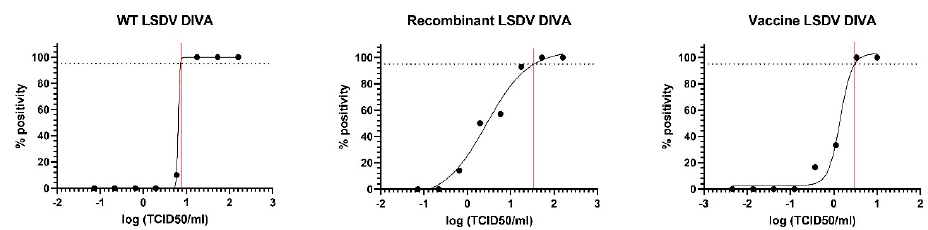
Figure 1. The non-linear regression analysis to determine the limit of detection of the DIVA PCR classical wild-type, recombinant wild-type, and Neethling vaccine LSDV for classical wild-type, recombinant wild-type, and Neethling vaccine LSDV strains.